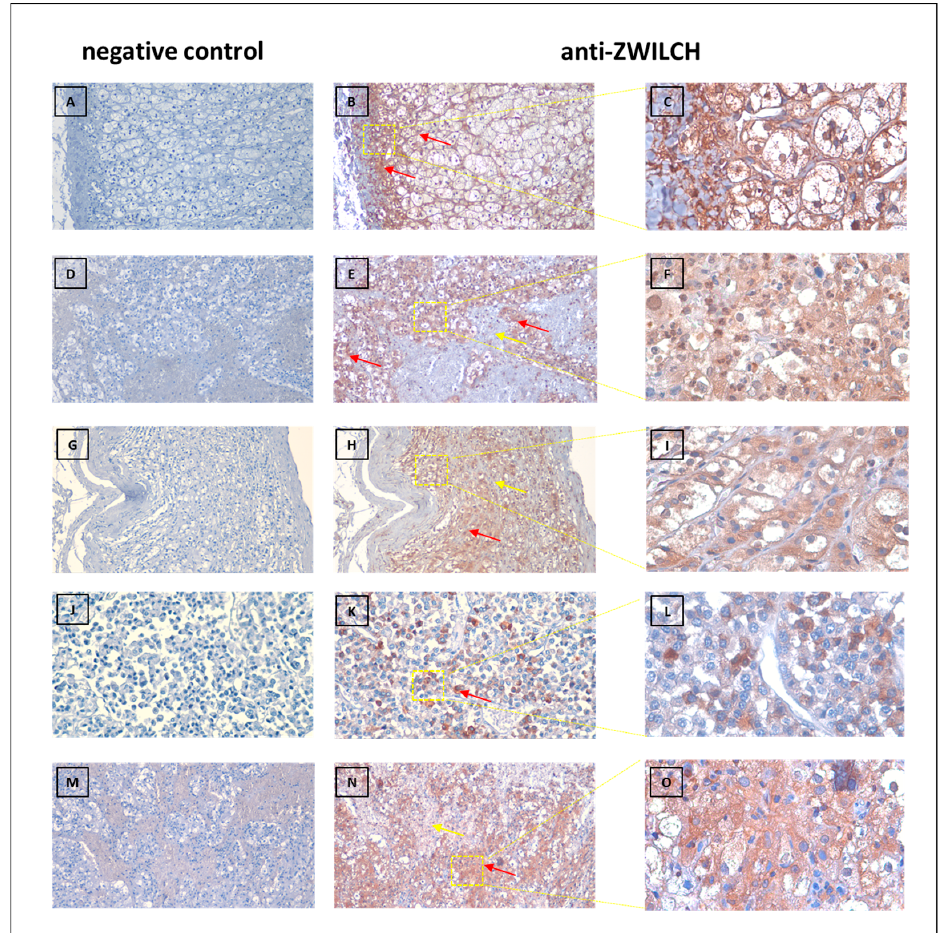
Figure 11. Representative immunostaining of adrenal gland disease spectrum (adrenal cancer pro- gression) TMA slide. Brown staining ( B , C , E , F , H , I , K , L , N , O ) indicates ZWILCH protein (red